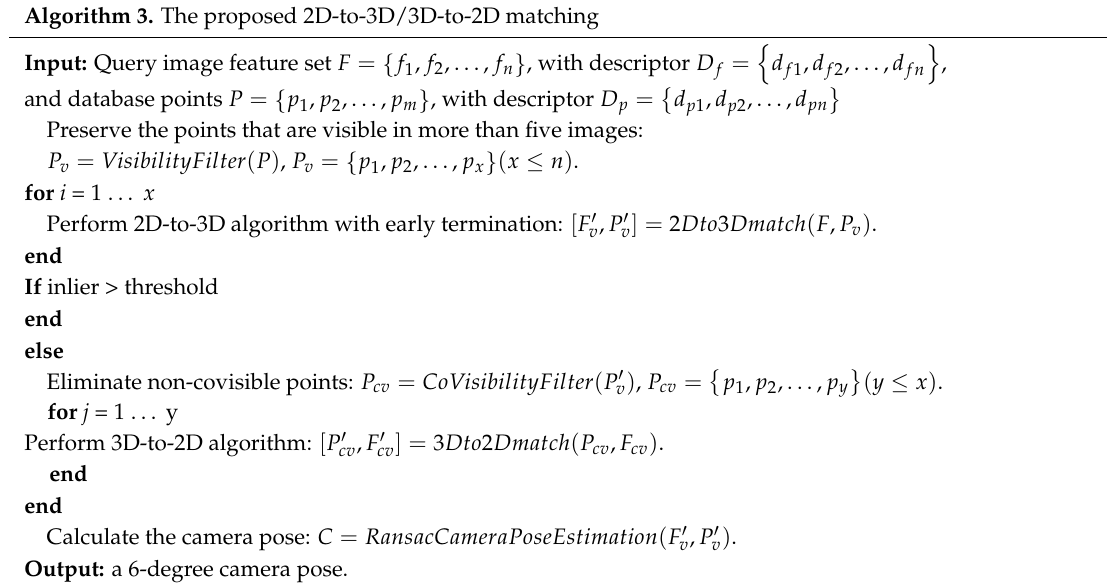
Algorithm 3. The proposed 2D-to-3D/3D-to-2D